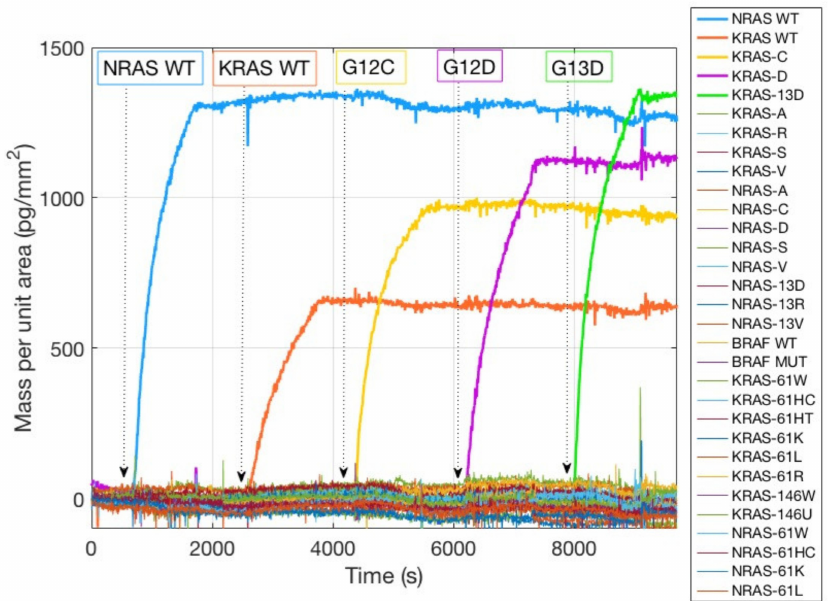
Figure 4. Binding curves obtained with the Interferometric Reflectance Imaging Sensor (IRIS) system for the specific capture of DNA target sequences. The five samples at 50 nM (NRAS WT, KRAS WT, G12C, G12D, G13D) were injected sequentially into the fluidic chamber and bound stably to their complementary probe (NRAS WT, KRAS WT, KRAS 12C, KRAS 12D, KRAS 13D, respectively, thick lines). No non-specific binding was detected on any of the other probes (thin